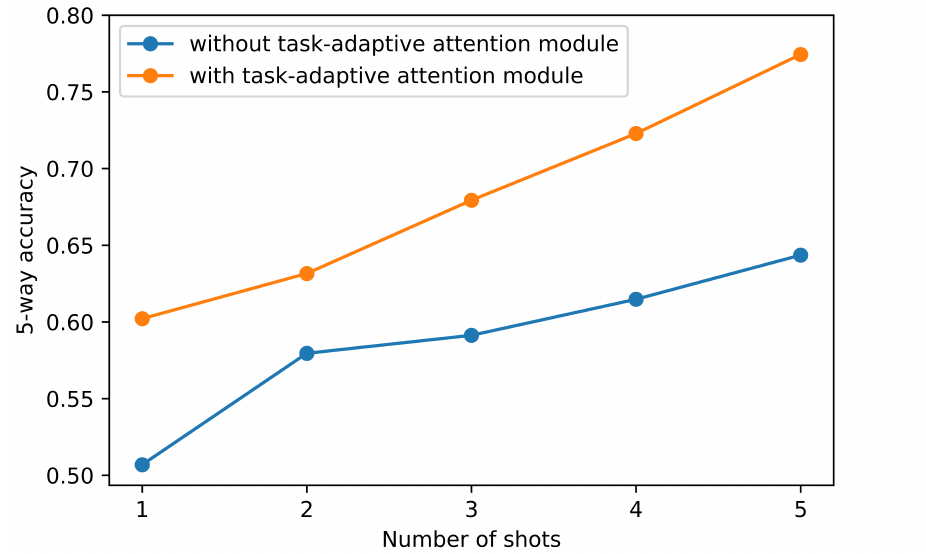
Figure 8. 5-way accuracies of the ablation analysis of task-adaptive attention module. When task- adaptive attention module is removed, the classification performance of the model degenerates dramatically in all